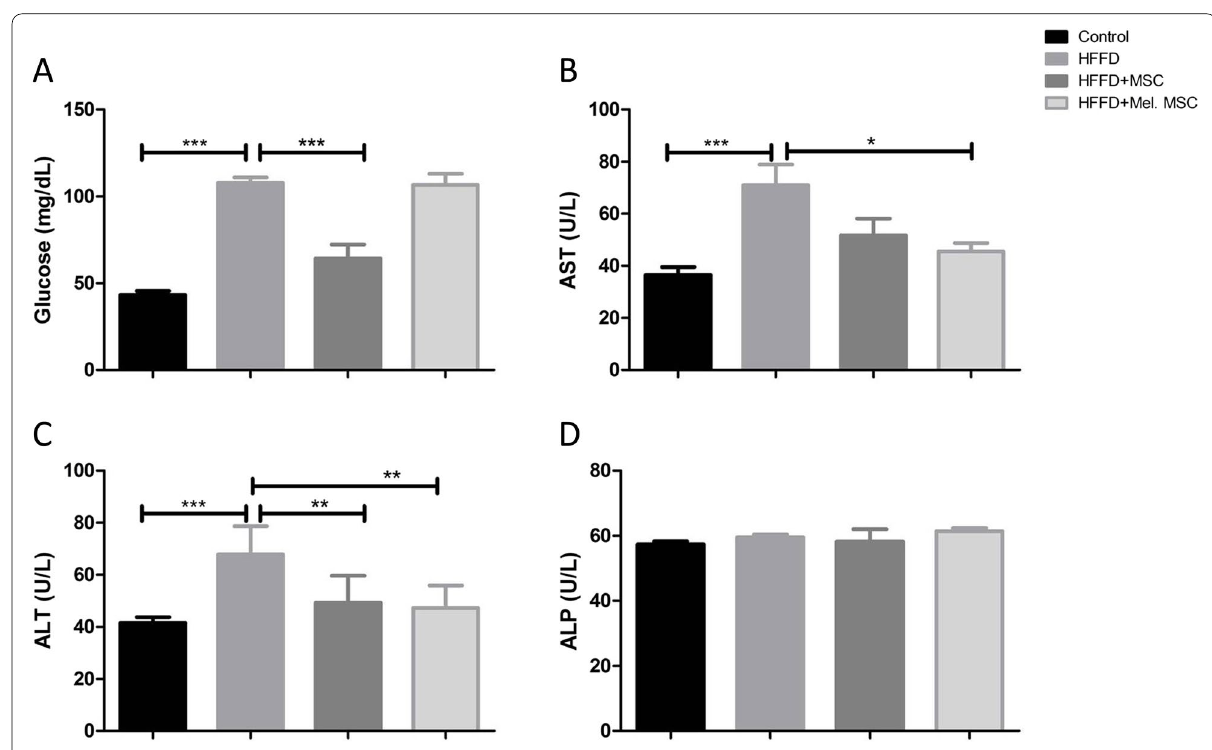
adipose-derived + Mel.MSC). Data expressed as +